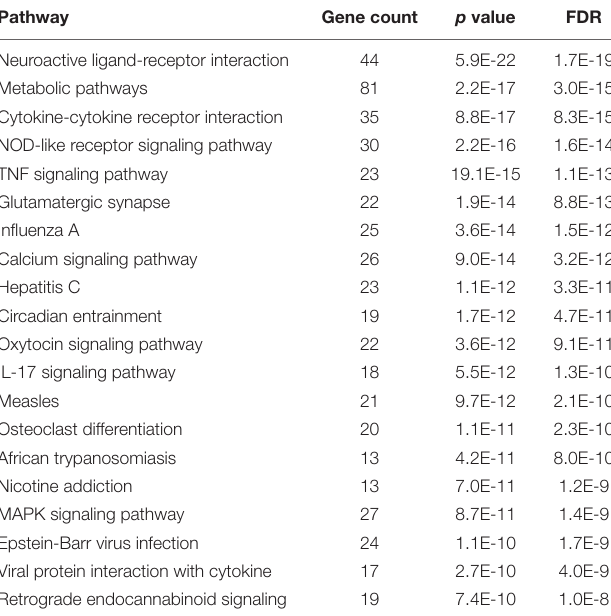
TABLE 2 | Top 20 upregulated genes, sorted according to p value. Symbol Gene